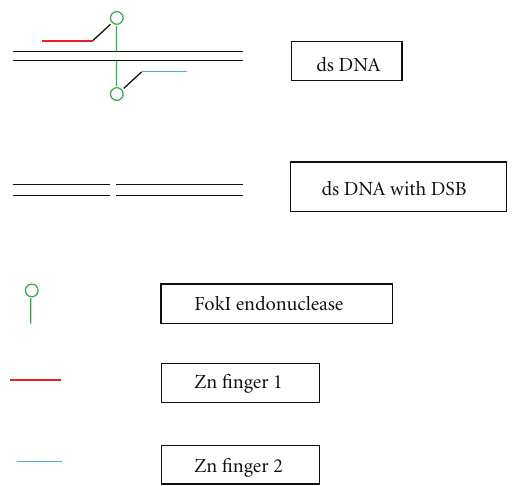
Figure 1: Generation of a double strand break by zinc finger nucleases, ds: double strand, DSB: double strand break, Zn: